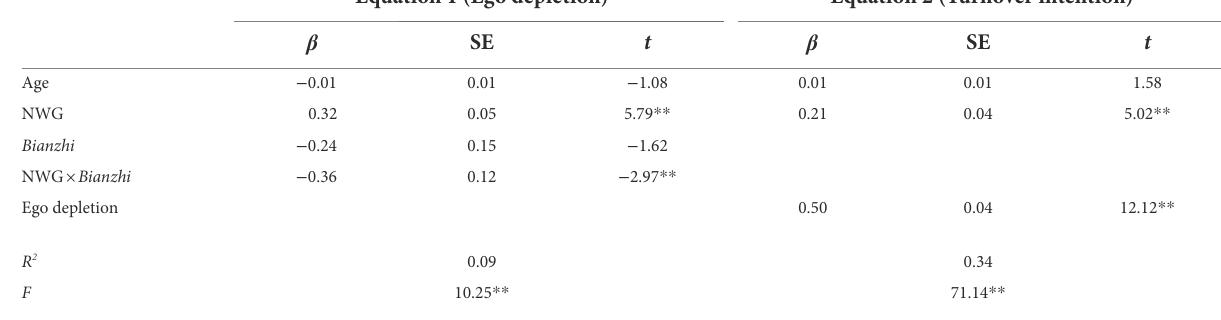
TABLE 3 Moderated mediation